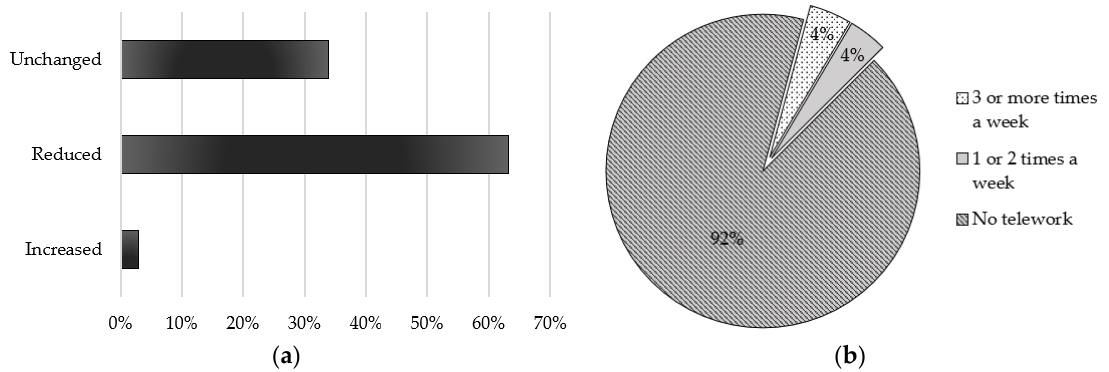
Figure 18. Mobility changes in the RMSC: ( a ) commuting after COVID-19; ( b ) teleworking in the RMSC.